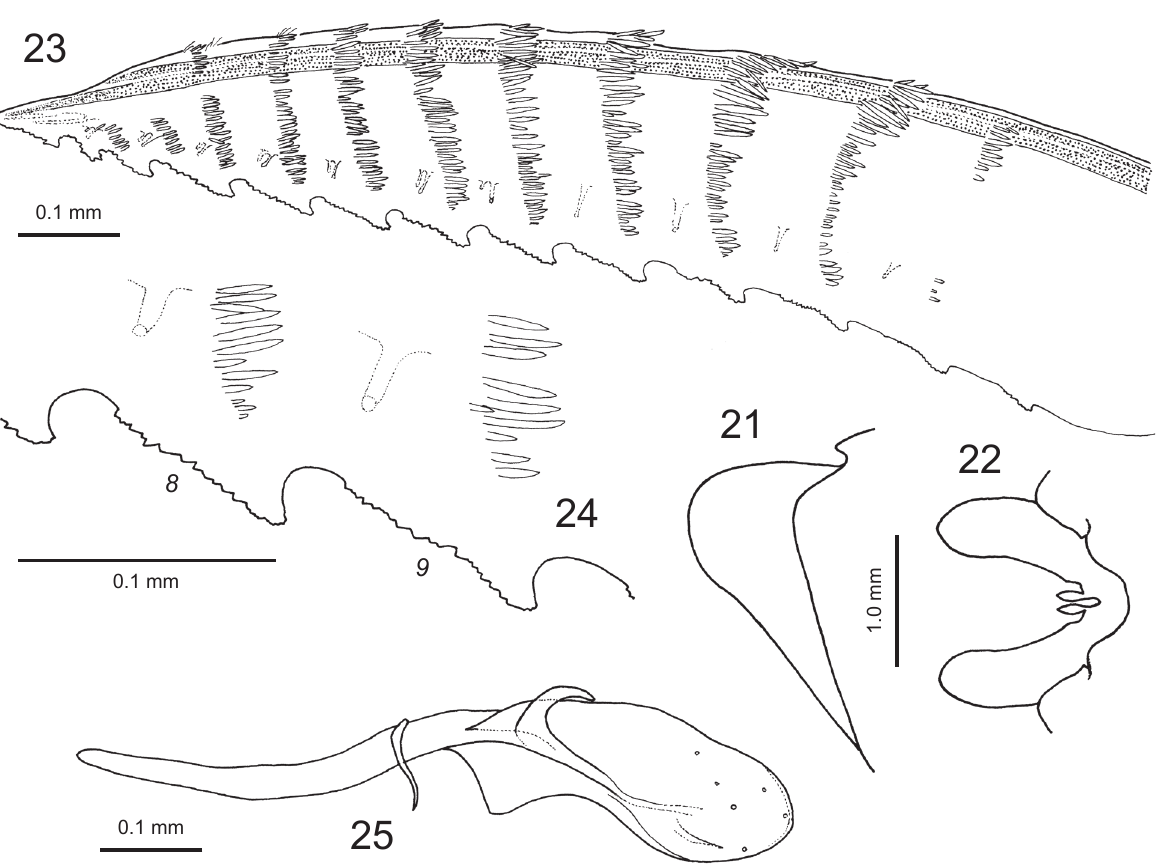
Figures 21–25. Pampsilota luederitzensis : 21. Valvulae 3 (lateral aspect); 22. Valvulae 3 (dorsal aspect); 23. Lancet; 24. Serrulae 8–9; 25. Penis valve (left, lateral